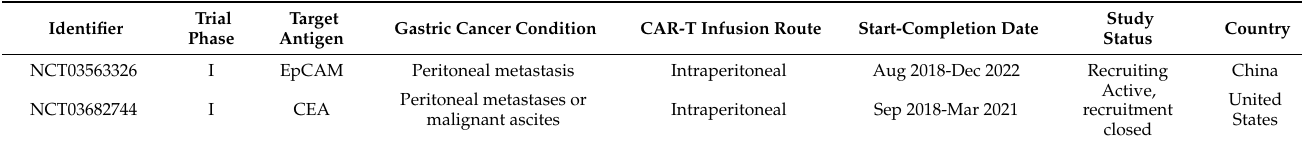
Table 2. Clinical trials with CAR-T cell therapy in peritoneal carcinomatosis of gastric origin (source: ClinicalTrials.gov (accessed on 25 October